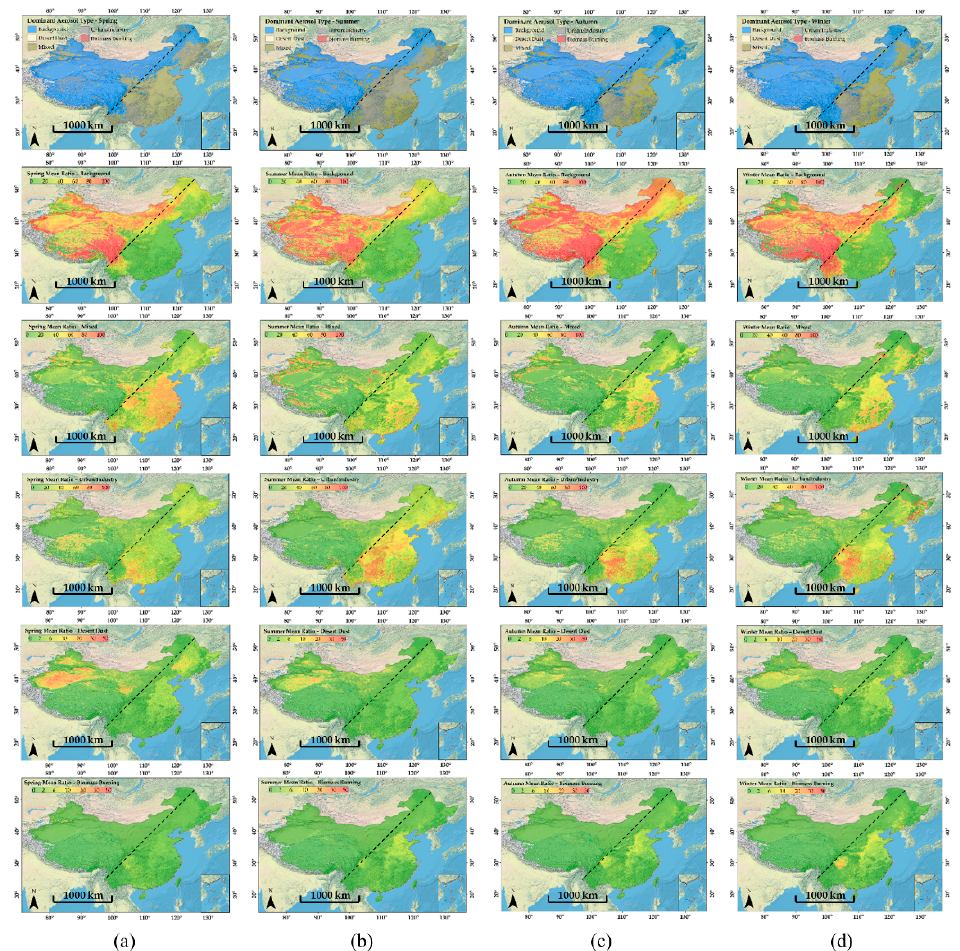
Figure 7. Spatial distribution of the dominant aerosol types and the mean ratios of different aerosol types in ( a ) spring March-April-May (MAM), ( b ) summer June-July- August (JJA), ( c ) autumn September-October-November (SON), and ( d ) winter December-January- February (DJF) over China during 2008 to 2017.